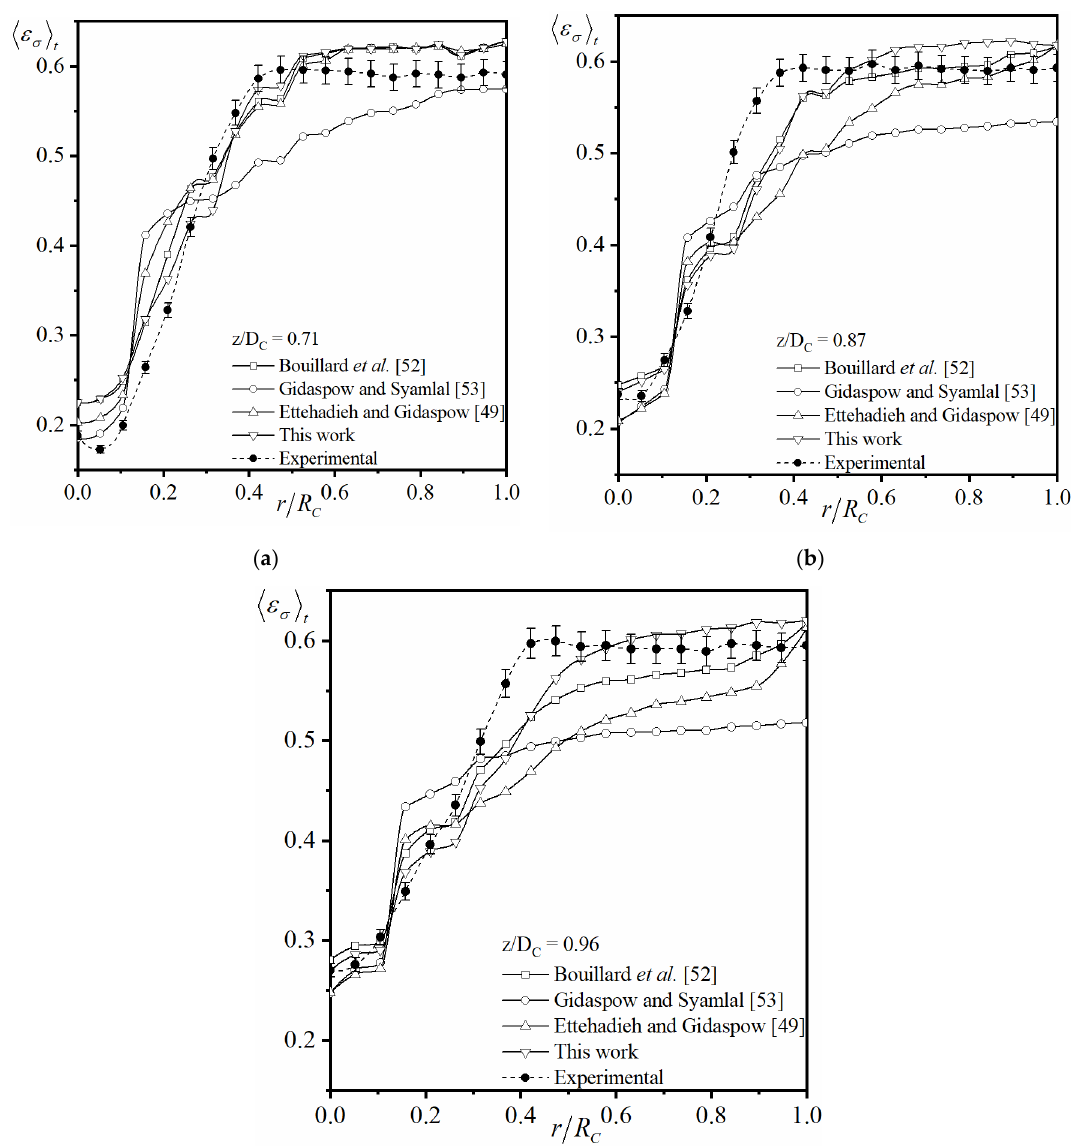
Figure 6. ( a ) Time-averaged predicted radial solids holdup profiles for spouted bed packed with 1 mm glass beads, H σ ,0 = 160 mm and / V ms = 1.1 at ( a ) z / D C = 0.71, ( b ) z / D C = 0.87, ( c ) z / D C = 0